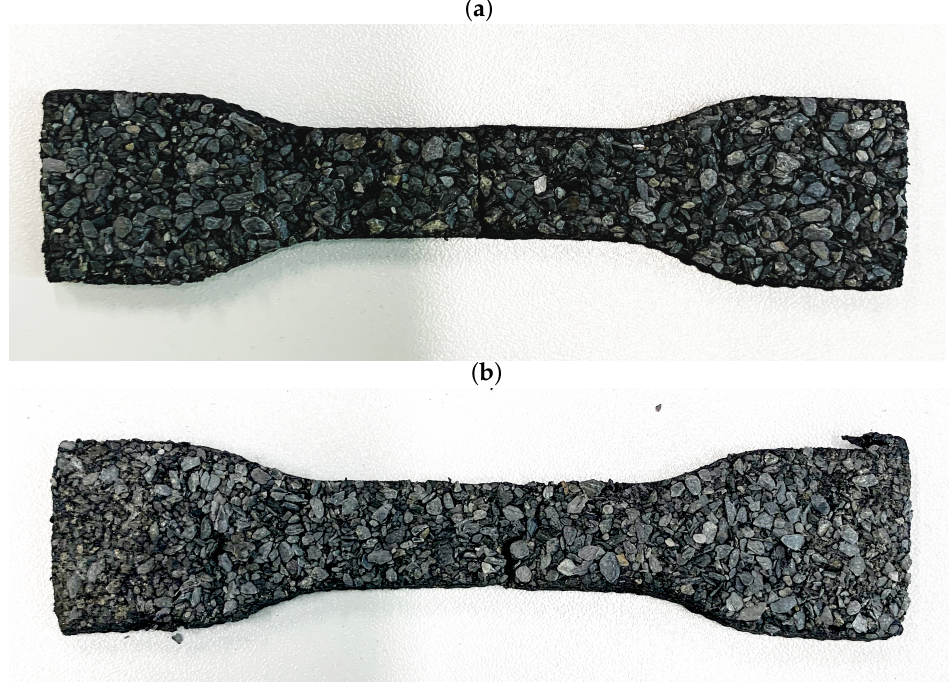
Figure 6. Samples after SH process: ( a ) sample cut a with knife, ( b ) sample after tensile